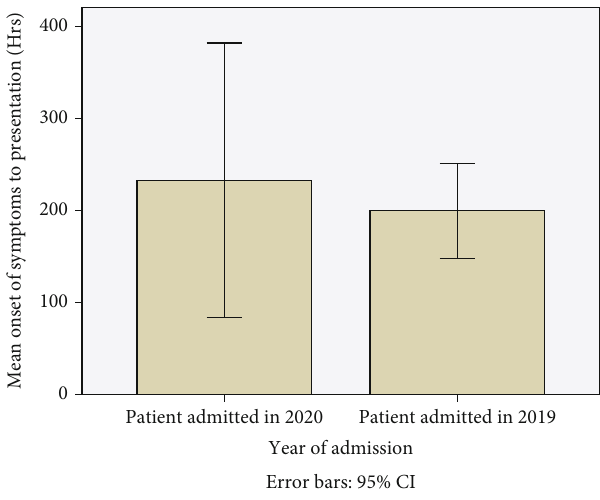
Figure 2: Number of active COVID-19 cases (total and per day) vs. number of AECOPD admissions/day.